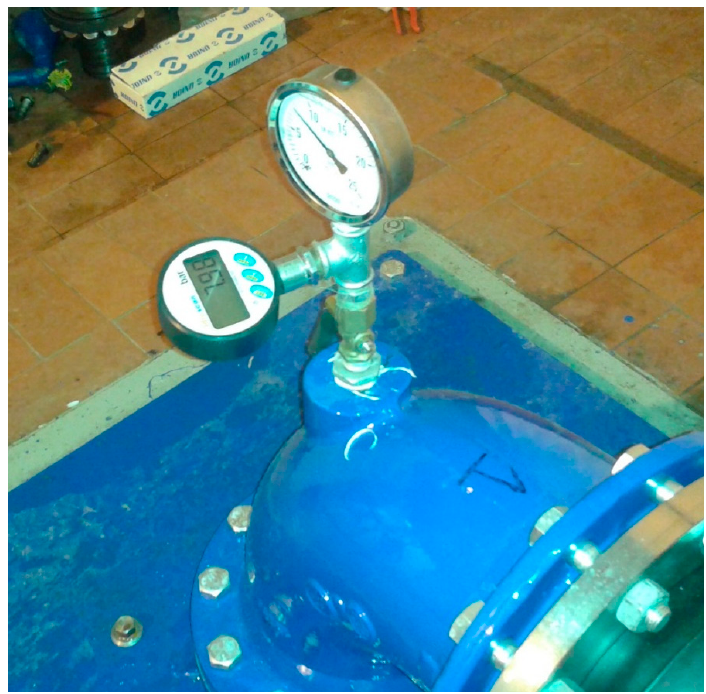
Figure 7. IDROSCAN digital manometer together with the analogue manometer. The measured values of pressure are given in Table 3. Table 3. Values obtained by using the presented method in the observed pumping station. Directly